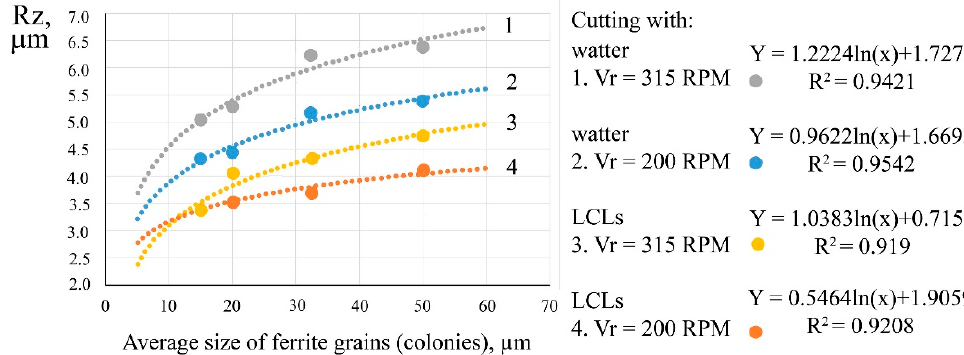
Figure 14. Influence of ferrite colony size on the surface roughness of 38Kh Н 3 М F А steel under lubrication conditions.